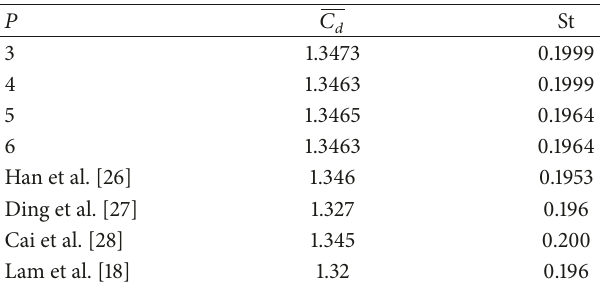
Figure 8: Local refined mesh around the circular cylinder. Table 1: Comparison of the mean drag coefficients and Strouhal